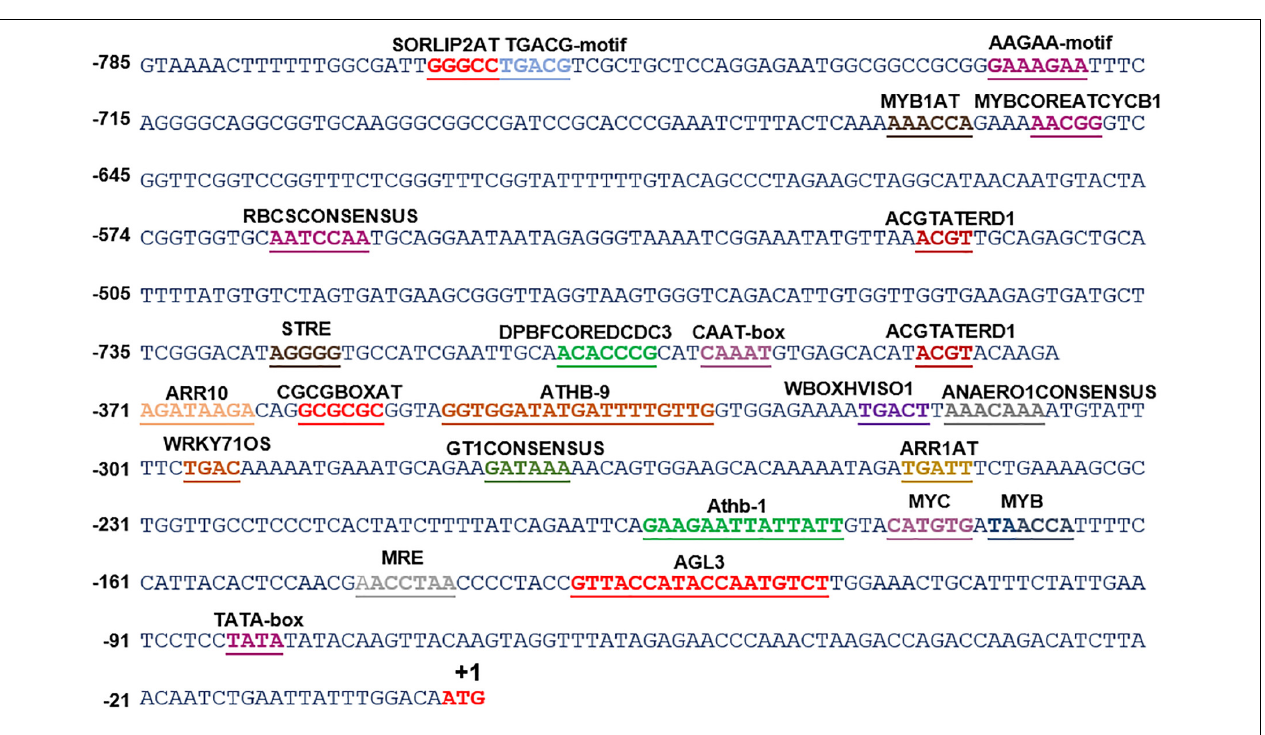
FIGURE 2 | In silico analysis of various cis -acting elements in ShSLD . The analysis indicated the presence of various stress-responsive elements, such as those responding to light, temperature, and dehydration cues. Putative cis -acting regulatory elements are named and underlined. +1 indicates the translation start